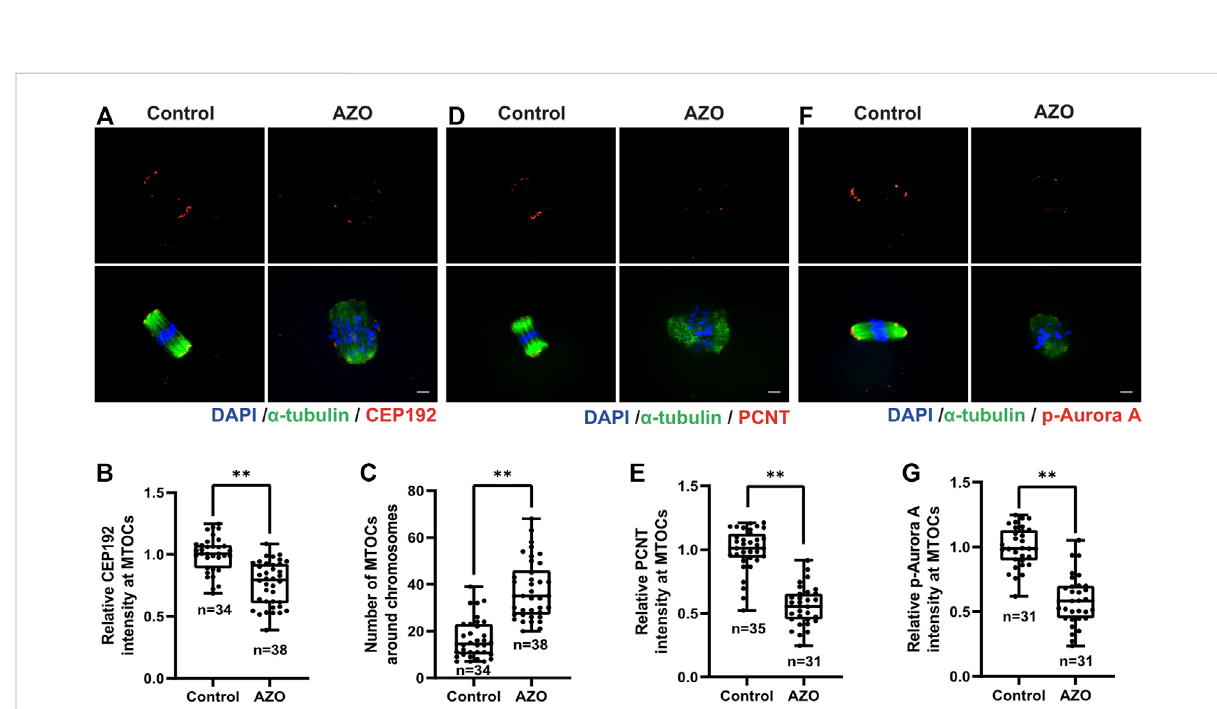
FIGURE 3 AZO exposure impairs acentriolar MTOC assembly during meiotic maturation. Oocytes were cultured with 5 μ M AZO for 8 h and stained with the indicated antibodies and DAPI. (A,D,F) Representative images of oocytes labeled with α -Tubulin, CEP192, PCNT, and p-Aurora antibodies. (A) . Scale bar, 10 μ m. (B,E,G) The intensities of CEP192, PCNT, and p-Aurora A around MTOCs are quanti fi ed. (C) The number of MTOCs around chromosomes is quanti fi ed using CEP192 fl uorescent foci. All data are expressed as mean ± SEM. ** p <